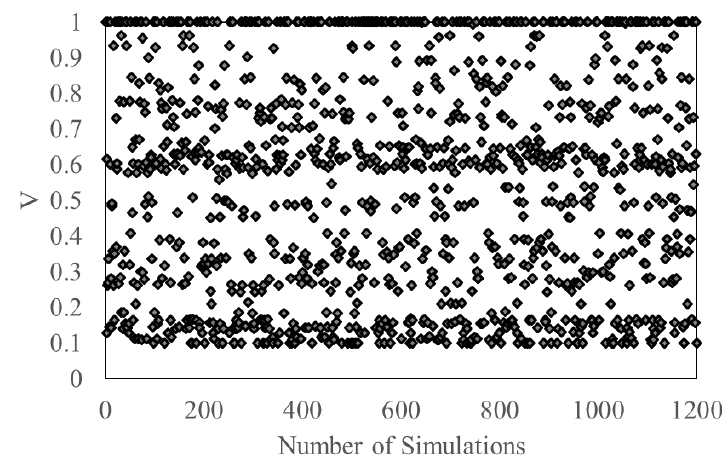
Figure 4. The normalized data spread showing the distribution of base shear.